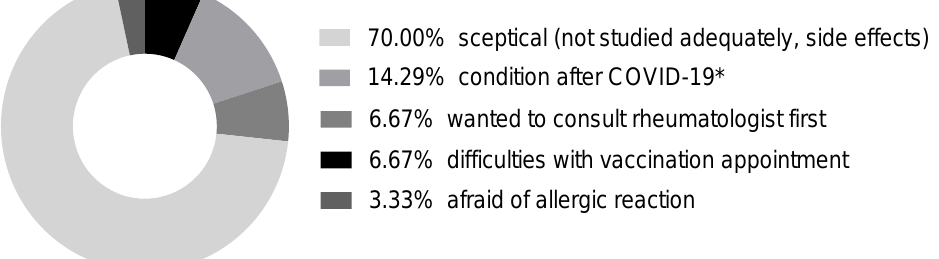
Figure 2. Reasons for non-vaccination, n = 29. * — For people after symptomatic COVID-19 infection, a single-shot vaccination 6 months afterward is recommended [10].